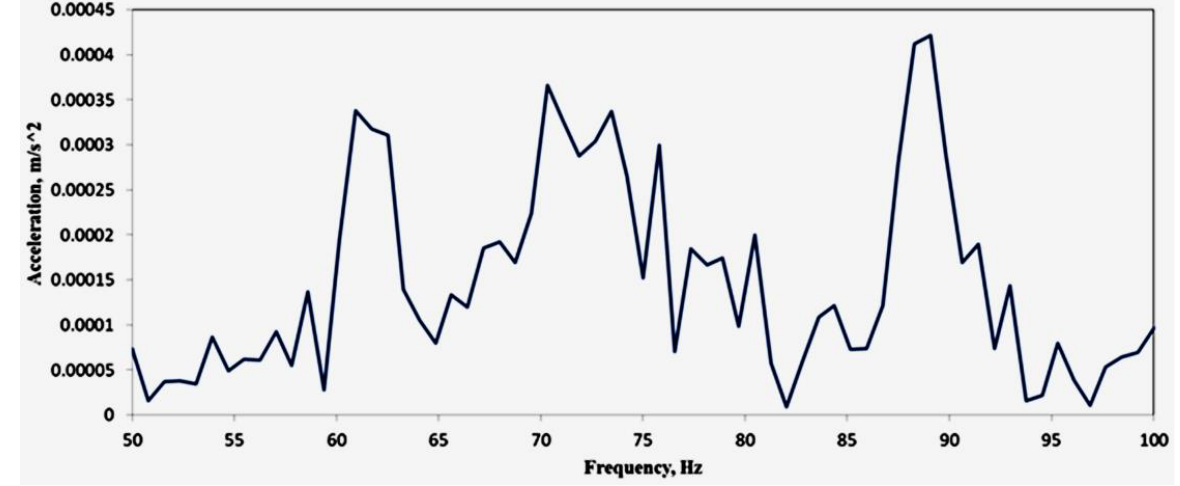
Figure 11. FRF of two cracks in adjacent blades.